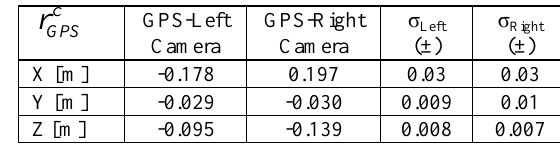
Table 4. Leverarm displacement vector in the camera